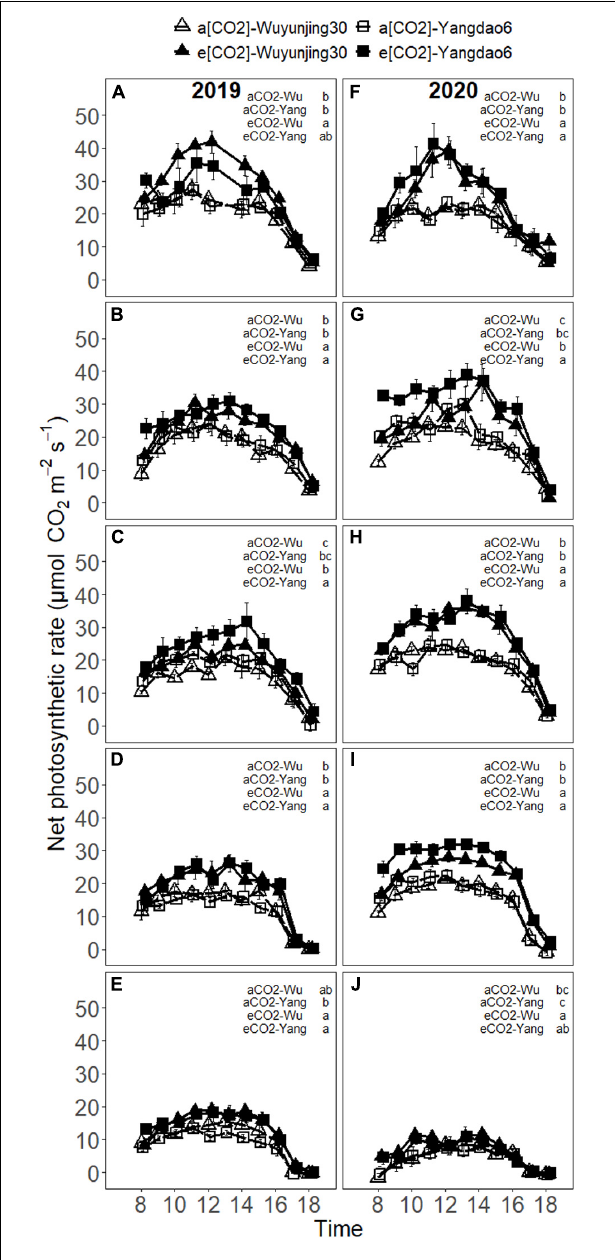
FIGURE 2 | Diurnal variations in net photosynthetic rate (A net ) of rice cultivar Wuyunjing30 and Yangdao6 grown at ambient and elevated (CO 2 ) at jointing (A,F) , booting (B,G) , heading (C,H) , grain-filling (D,I), and maturity (E,J) stages in 2019 and 2020. Values were expressed as means ± standard errors form. Values of A net under four (CO 2 ) × cultivar treatments at 13 p.m. at jointing stage in 2019 were deleted because of the abnormal values found by examination. Statistical analyses of multiple comparisons for five growing stages in 2 years were shown in each panels of the figure in the form of lowercase